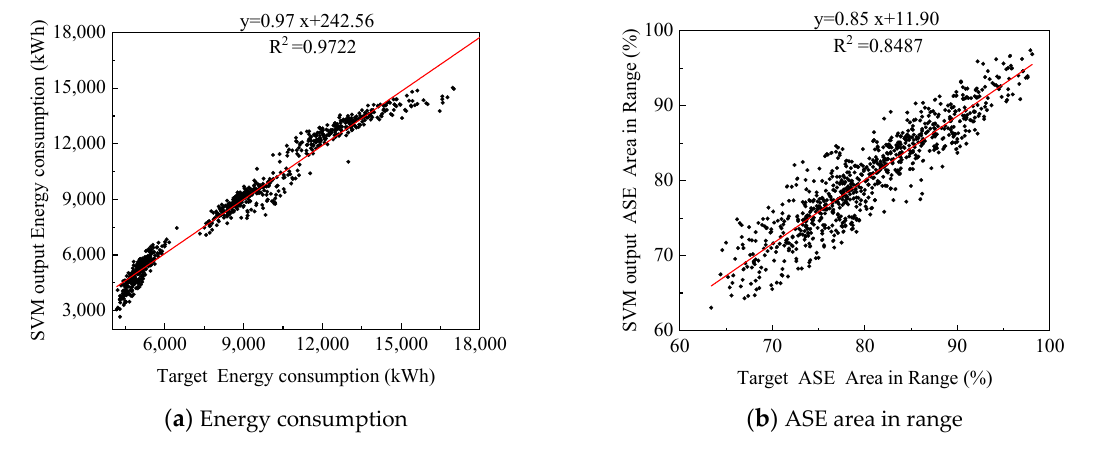
Figure 6. SVM model output and target fitting diagram.